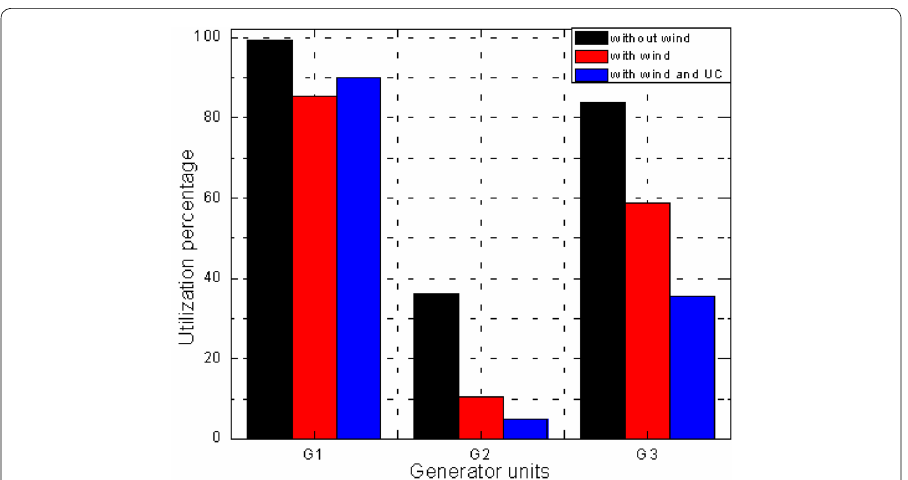
Fig. 13 Utilization percentage of generators for various load and wind profiles using proposed MGWOSCACSA